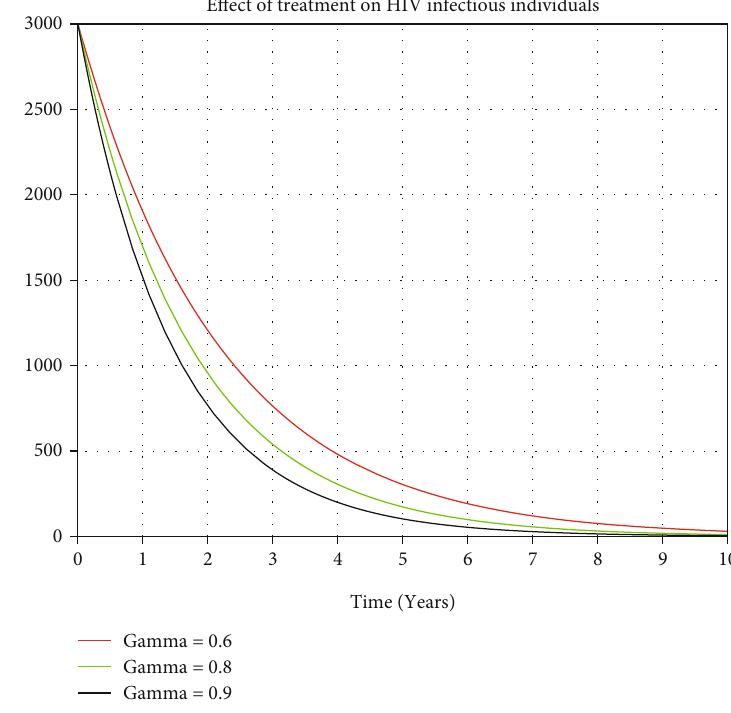
Figure 11: E ff ect of treatment on HIV/AIDS infectious